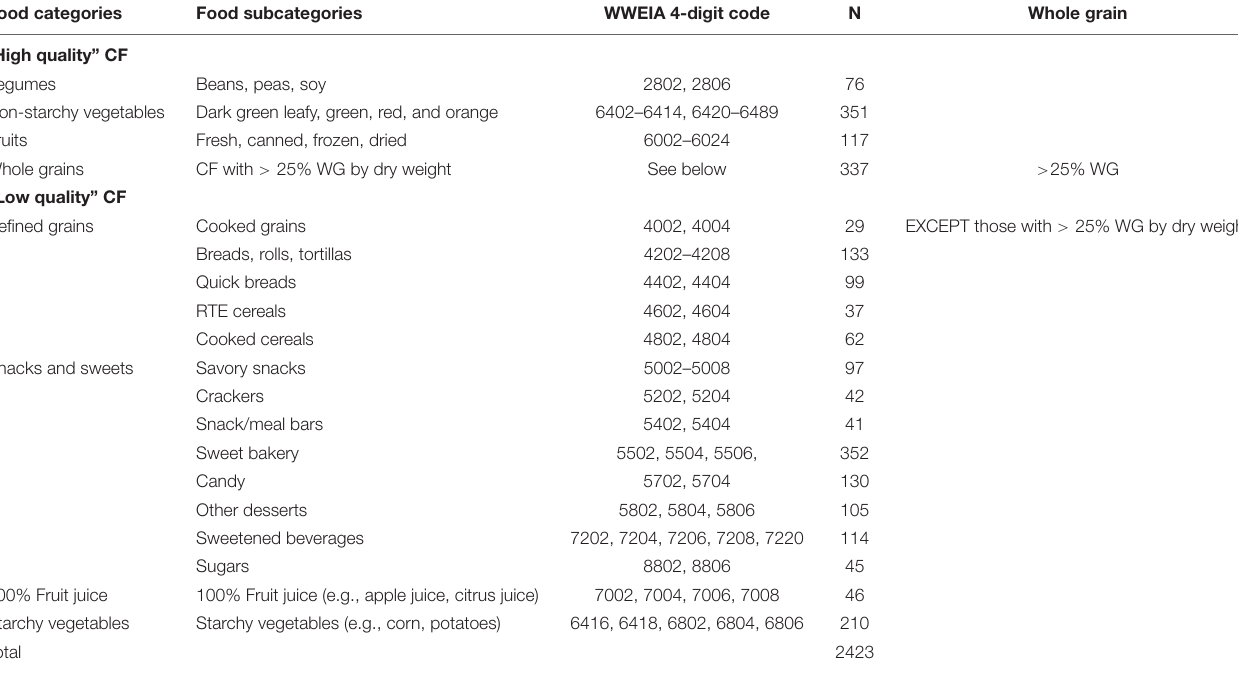
TABLE 1 | Carbohydrate foods (CF) in the FNDDS 2017-18 database classified by What We Eat in America 4-digit codes and by “high quality and “low quality” assignments in refs (4, 5). Food